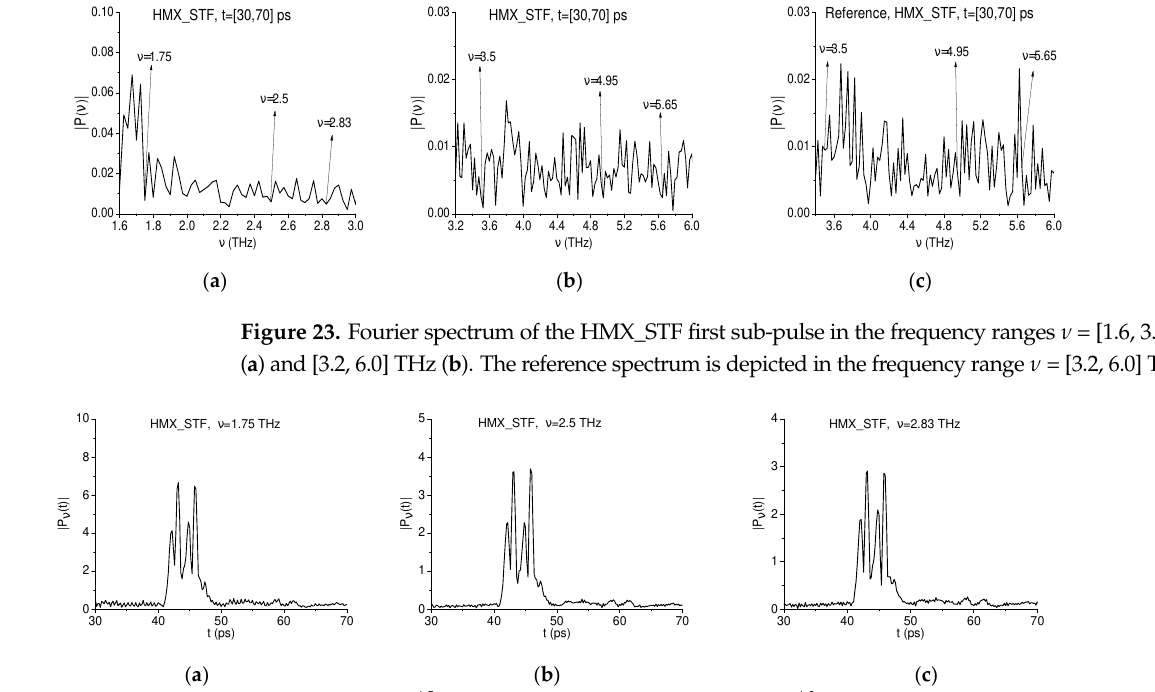
Figure 23. Fourier spectrum of the HMX_STF first sub-pulse in the frequency ranges ν = [1.6, 3.0] THz ( a ) and [3.2, 6.0] THz ( b ). The reference spectrum is depicted in the frequency range ν = [3.2, 6.0] THz ( c ).